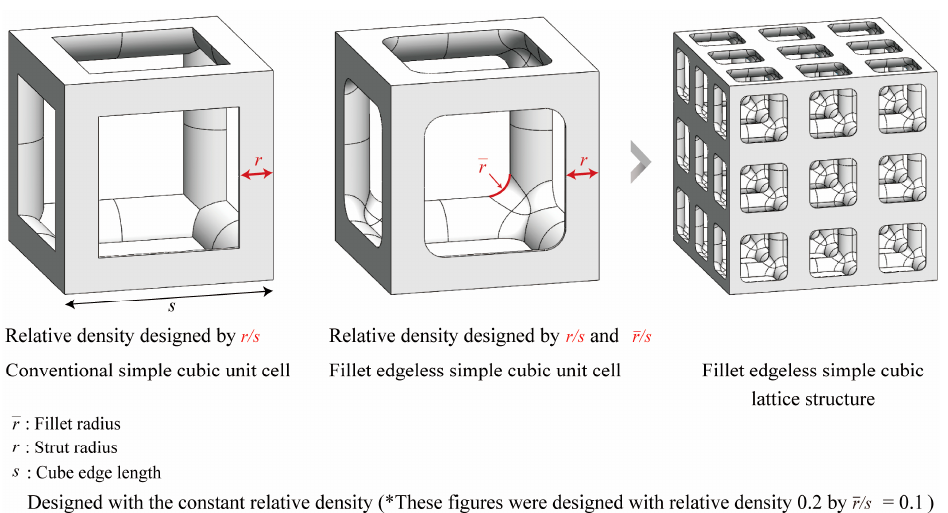
Figure 6. Schematics of the fillet edgeless simple cubic lattice structure. The structures were designed with a constant relative density of 0.2 and 𝑟̅/𝑠 = 0.1. Table 1 and Figure 7 show the database for the fi llet edgeless simple cubic unit cell design with relative densities of 0.1, 0.2, and 0.3. In this study, 𝑟̅/𝑠 was provided from 0.01 to 0.25, in increments of 0.01. The morphologies of 12 fi llet edgeless simple cubic unit cells with a relative density of 0.2 and 𝑟̅/𝑠 ranging from 0.02 to 0.24 with an increment of 0.02 are shown in Figure 8, which were selected for the FEA validation. In this study, the length of the unit cell cube edge ( 𝑠 ) was fi xed at 20 mm. Table 1. Design database for fi llet edgeless simple cubic unit cell with relative densities of 0.1, 0.2, and 0.3.